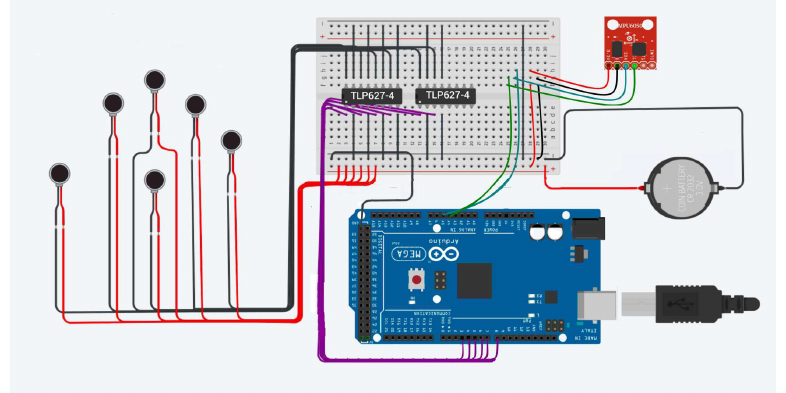
Figure 3. HMD Proposed